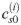
Damages in biofilm at 48h for 4 different concentrations of substrates.(a) cs0(i), (b) cs0(i)5, (c) cs0(i)10, (d) cs0(i)100. Damages level are depicted by colors from blue to red.